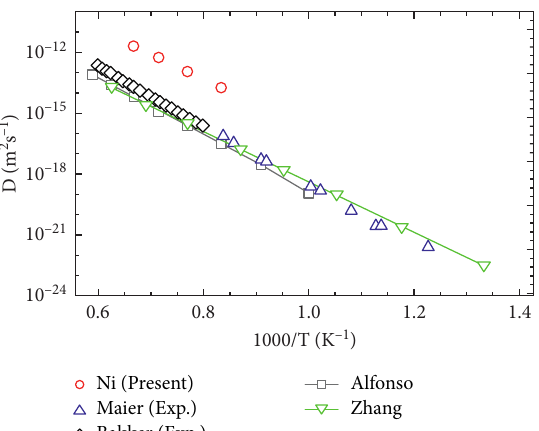
Figure 5: Self-diffusion coefficients for pure Ni at T � 1200K, 1300K, 1400K, and 1500K and its comparison with available experimental data [46, 47]. Available results derived from first-principle calculations are also shown [18, 43]. Table 2: ABC predicted and available effective vacancy energy barriers Q The available data are both based on experimental measurements and theoretically based values. Parameter Systems This work Experimental data Other results